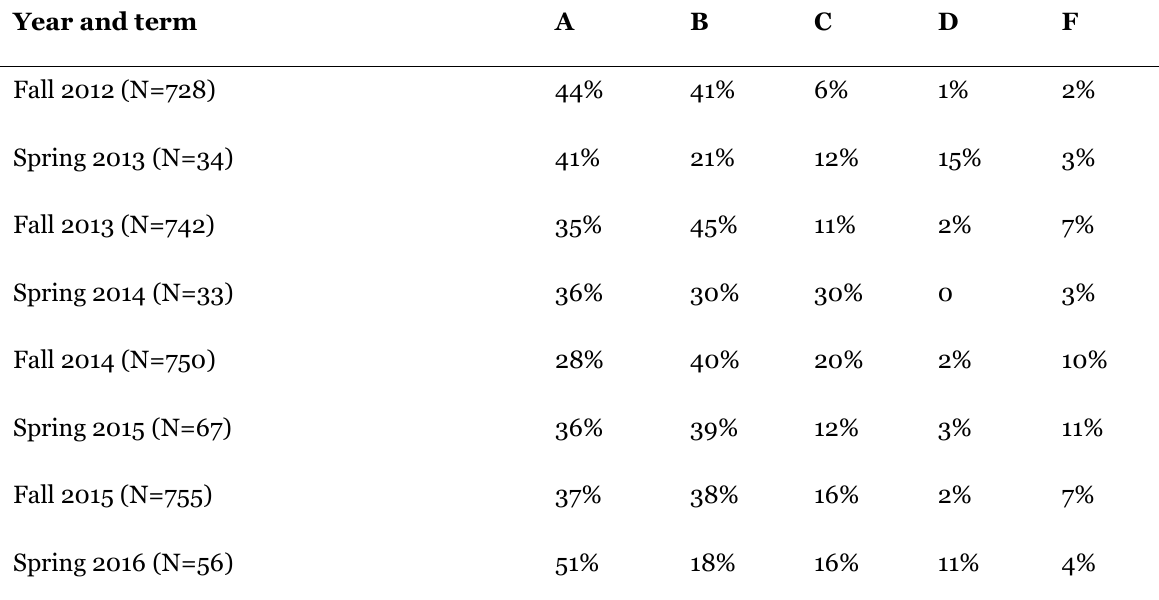
Data for Figure 2: Grades Distribution in Physics 100, Fall 2012-Spring